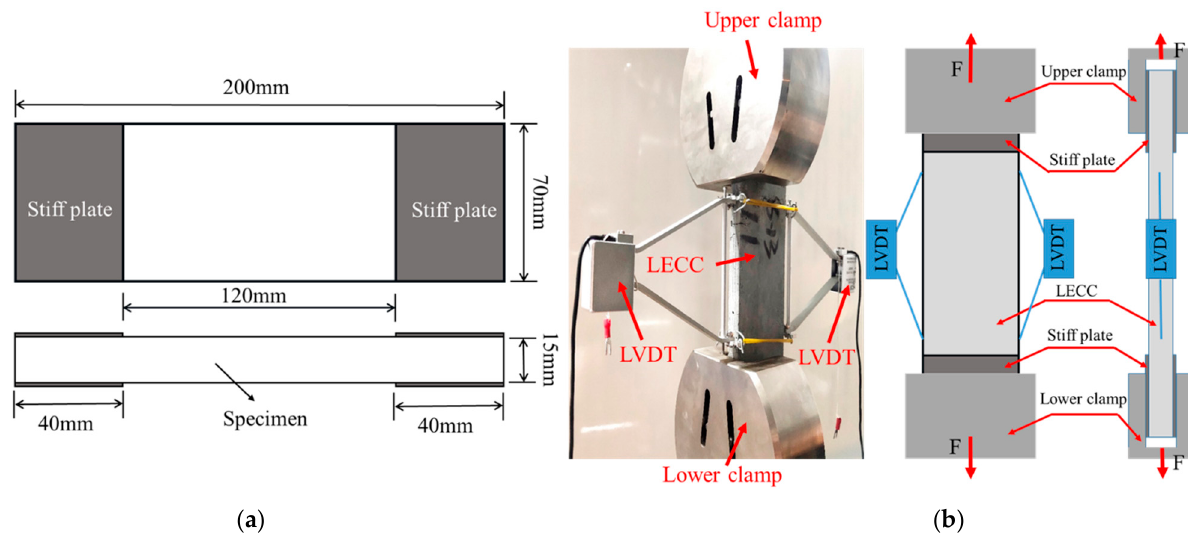
Figure 3. ( a ) Dimensions of the TR-LECC specimen and ( b ) test setup.